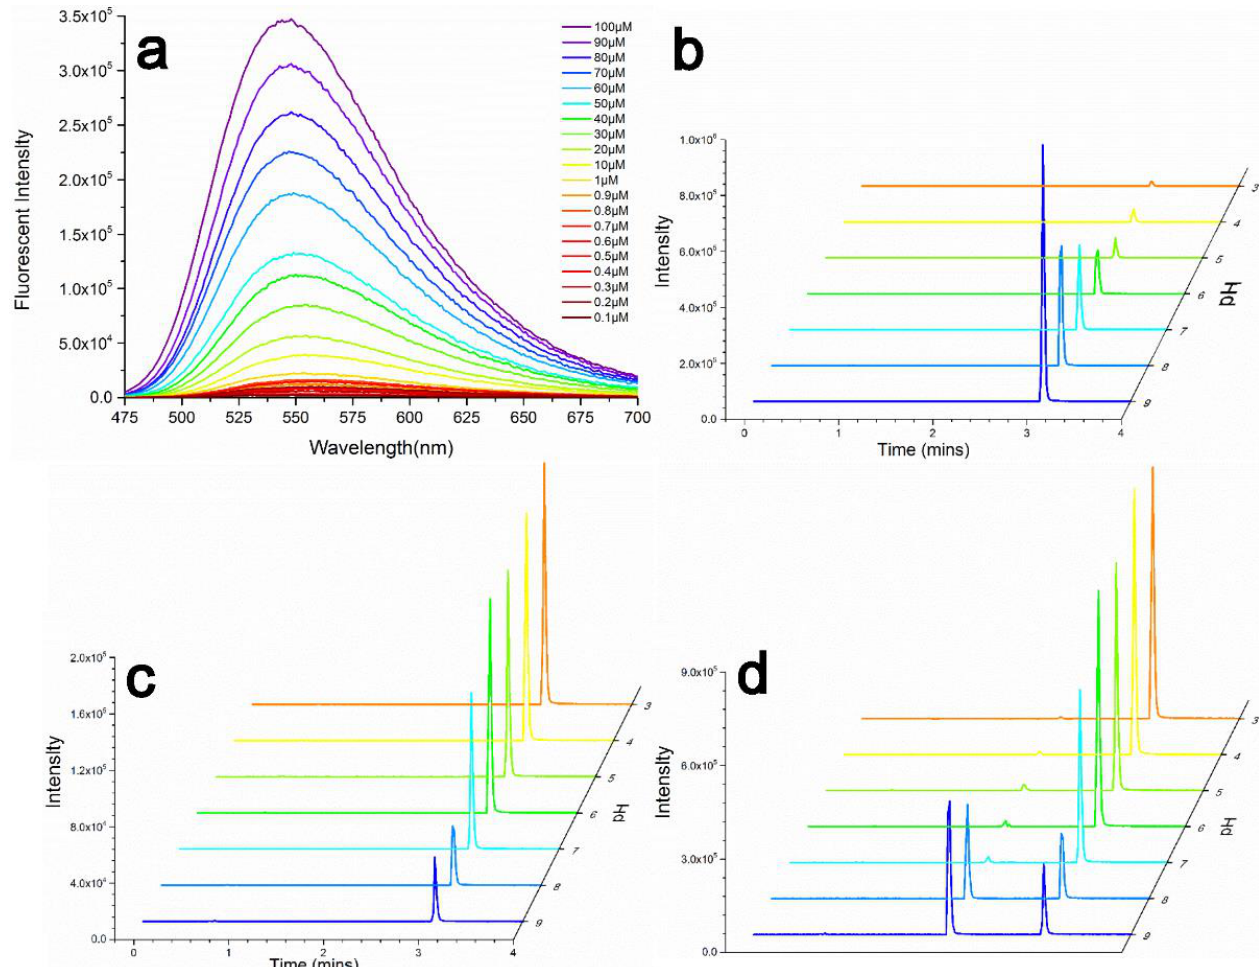
Figure 2. ( a ) fluorescence emission spectra of 10 mM GSH in 100 mM Tris-HCl buffer with 1% DMSO as co-solvent (V Water /V DMSO = 99:1) at different Nap-I concentrations in the range 0–100 μM; ( b ) alkylation efficiency of Cys by Nap-I at different pH; ( c ) alkylation efficiency of Sec by Nap-I at different pH; ( d ) competitive alkylation efficiencies of Cys and Sec by Nap-I.